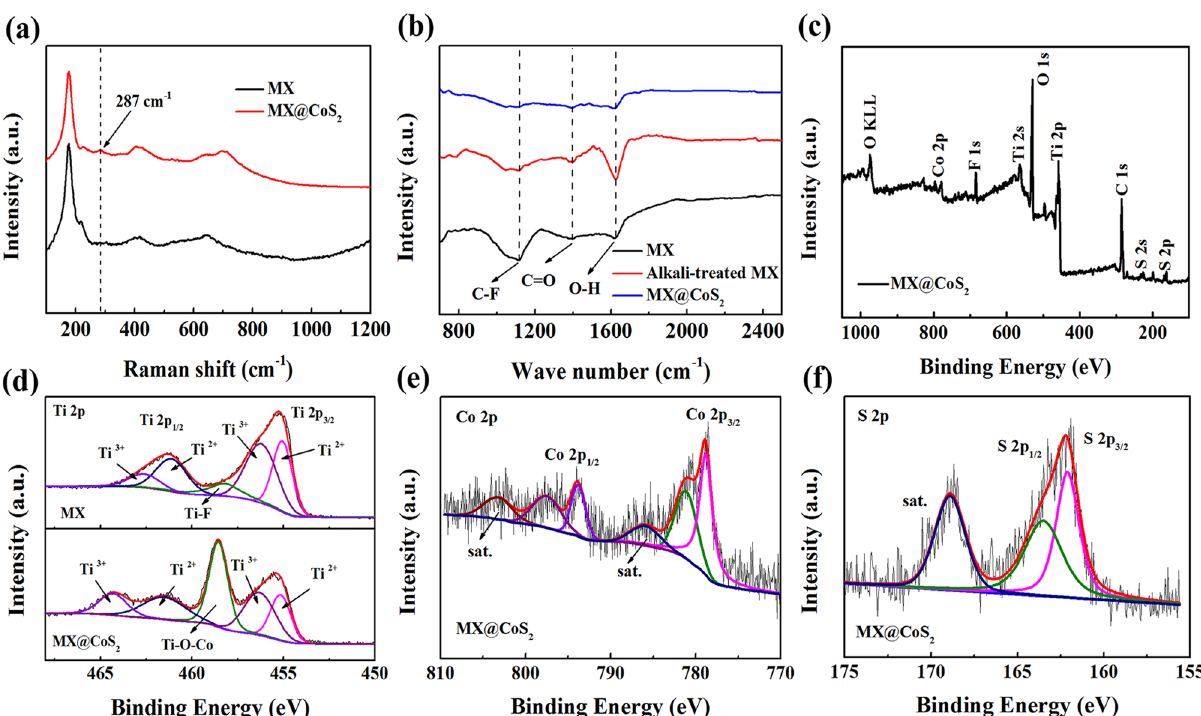
Fig. 2 a Raman spectra, b FT-IR spectra of MX and MX@CoS 2 . c XPS survey spectra of MX@CoS 2 . d XPS Ti 2 p spectra of MX and MX@ CoS 2 . e XPS Co 2 p and f XPS S 2 p spectra of MX@CoS